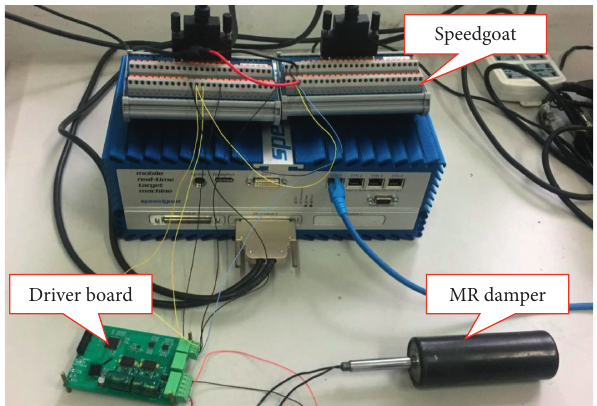
Figure 12: The experiment system